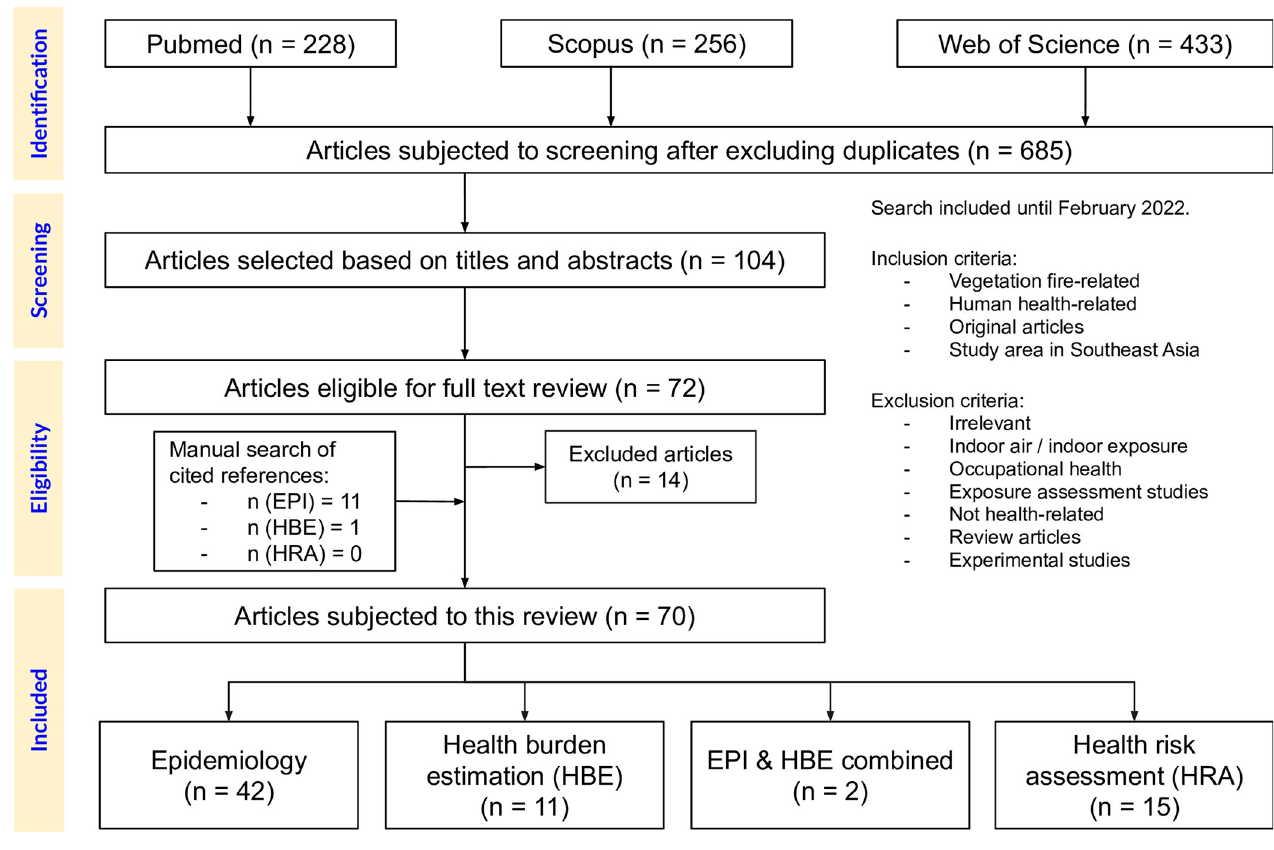
Fig 1. Flowchart of review